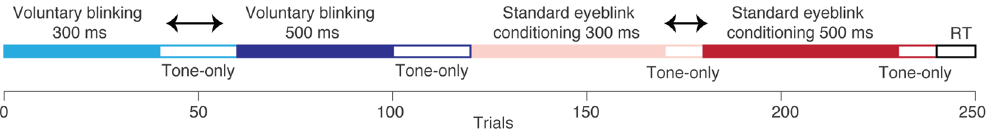
Figure 1. Experimental protocol. First, participants were trained to produce accurately timed blinks voluntarily (light and dark blue) in response to a tone, using visual feedback or a click sound. The target time was first 300 ms and then 500 ms, or vice versa. After each voluntary training session (40 trials), the participants were instructed to continue to blink to the tone with the same delay, but without the feedback. Next, participants were trained in a standard eyeblink conditioning protocol (light and dark red) with the same two intervals. Training consisted of 50 trials with 20 percent probes, followed by 10 tone only trials. In the last ten trials participants were instructed to blink as rapidly as